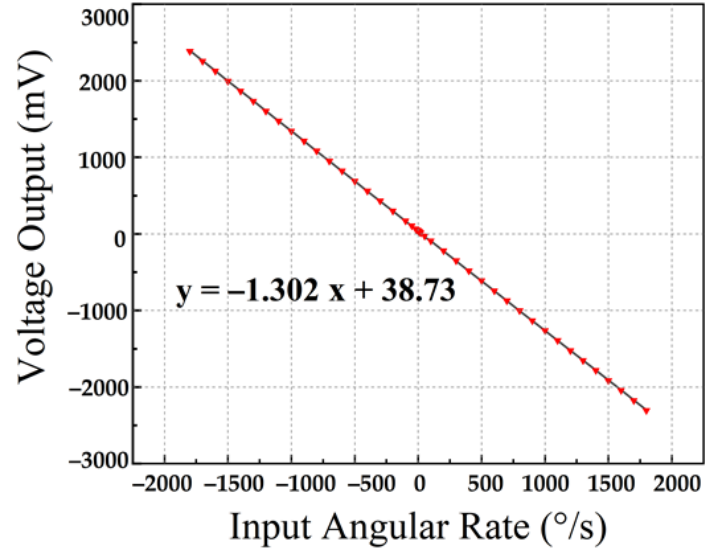
Figure 11. Full-scale testing results and nonlinearity of BFVG.